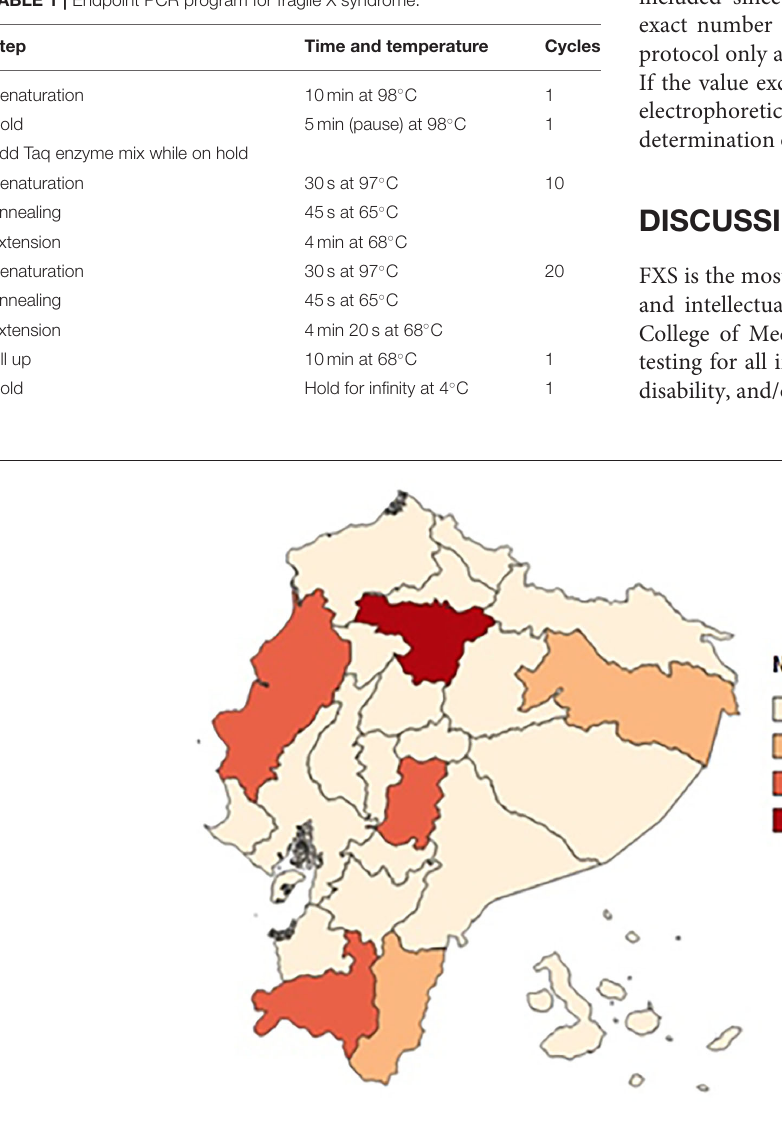
FIGURE 1 | Map of Ecuador with positive case distribution by provinces. The Pichincha Province has 14 positive cases; the Guayas, Loja, and Chimborazo Provinces have 2; and the Orellana and Zamora Chinchipe Provinces have 1 positive case.